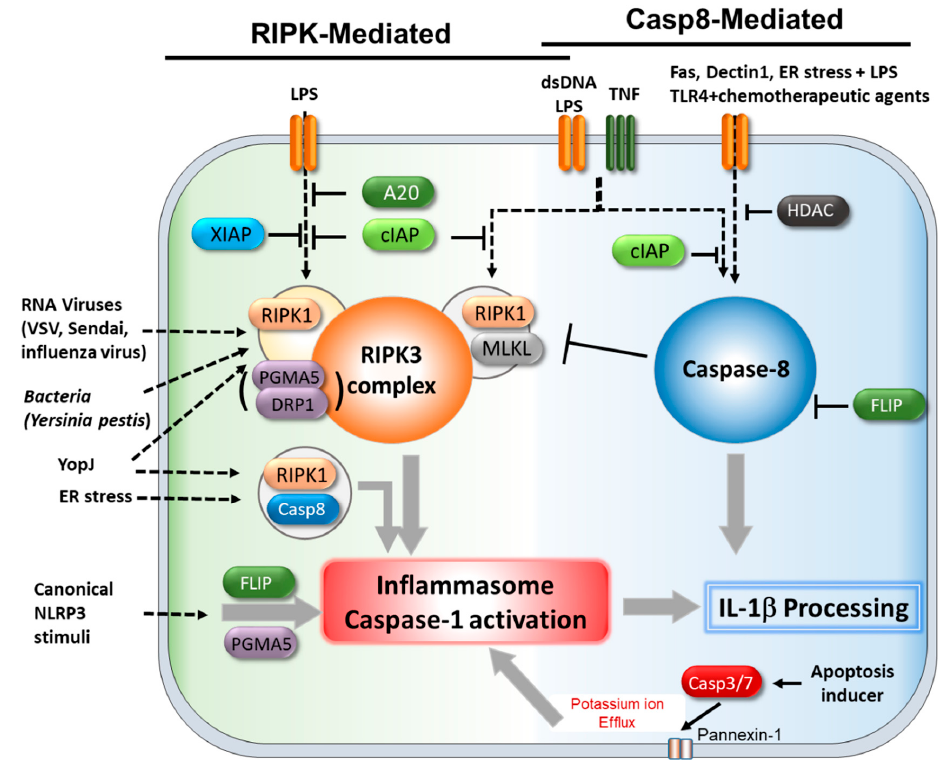
Figure 4. Roles of necroptosis molecules in inflammasome activation and IL-1 β processing. Apoptosis- or necroptosis-related molecules contribute to inflammasome activation and IL-1 β processing through two distinctive pathways. One is through the protein kinase RIPK-complex, the other one is through caspase-8. Caspase-8 can directly cleaves pro-IL-1 β upon stimulation with stimuli such as FasL, Dectin-1, and LPS combined with chemotherapeutic drugs, as well as the inhibition of HDAC. The caspase-8 function in these processes could be inhibited by c-FLIP. Caspase-8 can also promote the activation of inflammasome or caspase-1 in response to YopJ and endoplasmic reticulum (ER) stress. The disruption of some genes, including A20, cIAPs, and XIAP, induces RIPK3-complex-mediated inflammasome activation upon stimulation with a TLR-agonist and TNF. Pathogenic infection, such as RNA viruses and bacteria, induce inflammasome activation through the RIPK1–RIPK3 complex. Depending on the stimuli, the RIPK1–RIPK3 complex promotes inflammasome activation with the help of DRP1 and PGAM5. PGAM5 and c-FLIP contribute to canonical NLRP3 inflammasome activation induced by LPS and ATP or monosodium urate (MSU). The disruption of caspase-8 leads to MLKL–RIPK3-mediated inflammasome activation. A caspase-3 / -7-mediated pannexin-1activation during apoptosis promotes NLRP3 inflammasome via potassium e ffl